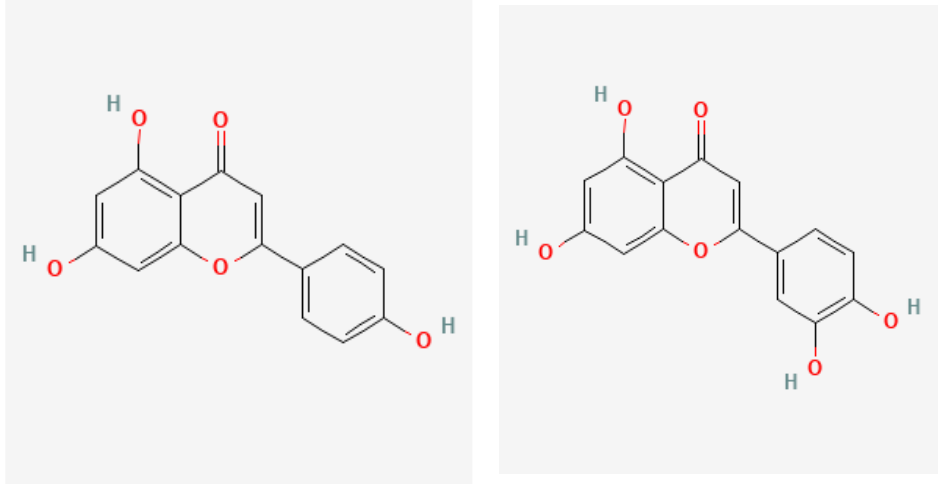
Figure 2. HPLC chromatogram of phenolics from GB leaves